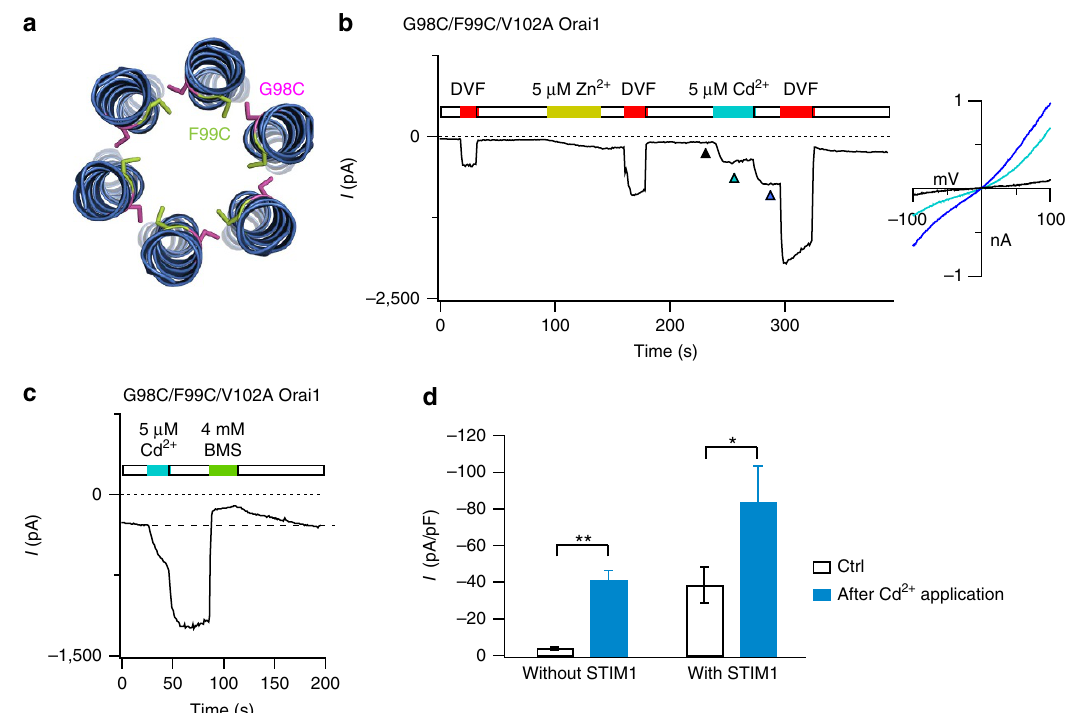
Figure 3 | Cd 2 þ and Zn 2 þ activate G98C/F99C channels through a lock-open effect. ( a ) Cartoon representation of the relative positions of engineered cysteine residues at G98 and F99 in neighbouring subunits based on the crystal structure of Drosophila Orai. The native residues were altered using the mutagenesis tool in PyMOL. ( b ) The transition metals ions, Zn 2 þ and Cd 2 þ , strongly enhance currents in G98C/F99C/V102A channels. Potentiation caused by Zn 2 þ and Cd 2 þ is partially reversed by washing the cell with DVF solution, indicating that it is caused by a lock-open effect from the trapping of the metal ions in the channel. Note that washout of Cd 2 þ reveals further current enhancement, indicating that Cd 2 þ also blocks the potentiated G98C/F99C double cysteine channels probably by binding to a second, low-affinity site. The I – V relationships at the time points indicated by the arrowheads are shown in the right graph. ( c ) Potentiation of G98C/F99C/V102A current by Cd 2 þ is rapidly reversed by the reducing agent BMS, likely through destabilization of the thiolate groups trapping Cd 2 þ . ( d ) Summary of Cd 2 þ potentiation in G98C/F99C/V102A channels in the absence and presence of STIM1. Cd 2 þ potentiates G98C/F99C/V102A channels to a greater extent in the absence of STIM1 than its presence, likely because F99C side-chains have already moved away from the pore axis in the presence of STIM1 . n ¼ 6 cells per condition. **: P o 0.001. *: P o 0.05. Paired t -test. Values are mean ±